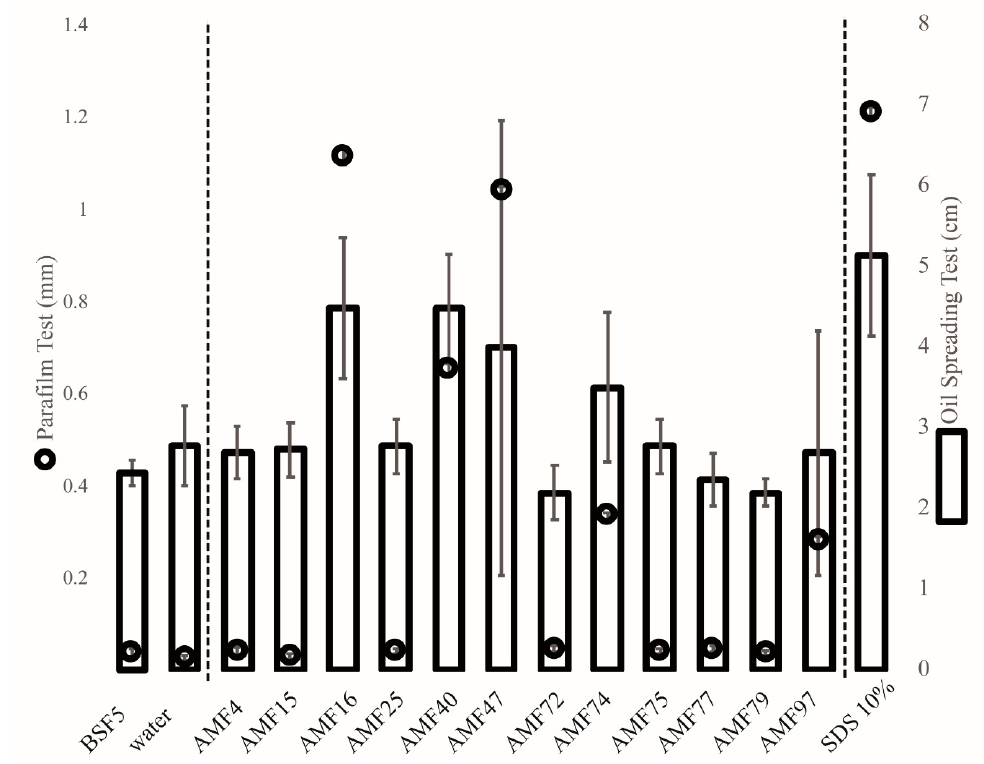
Figure 4. Ability of selected fungal isolates to produce biosurfactants based on the oil spreading test ( n = 3) and the parafilm test ( n = 7). AMF4: Penicillium chrysogenum ; AMF15: Aspergillus sydowii ; AMF16: Penicillium polonicum ; AMF25: Penicillium steckii ; AMF40: Penicillium cyclopium ; AMF47: Penicillium cyclopium ; AMF72: Penicillium olsonii ; AMF74: Penicillium cyclopium ; AMF75: Aspergillus versicolor ; AMF77: Aspergillus sydowii ; AMF79: Penicillium mononematosum and AMF97: Aspergillus versicolor